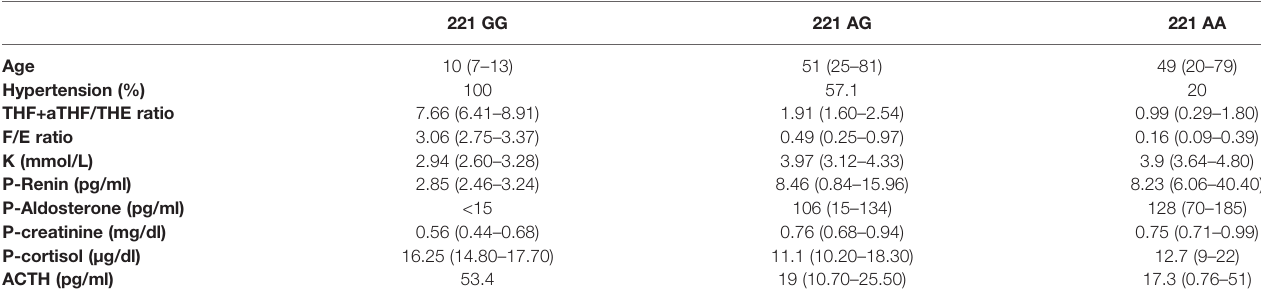
TABLE 1 | Characteristics of the AME family members according to